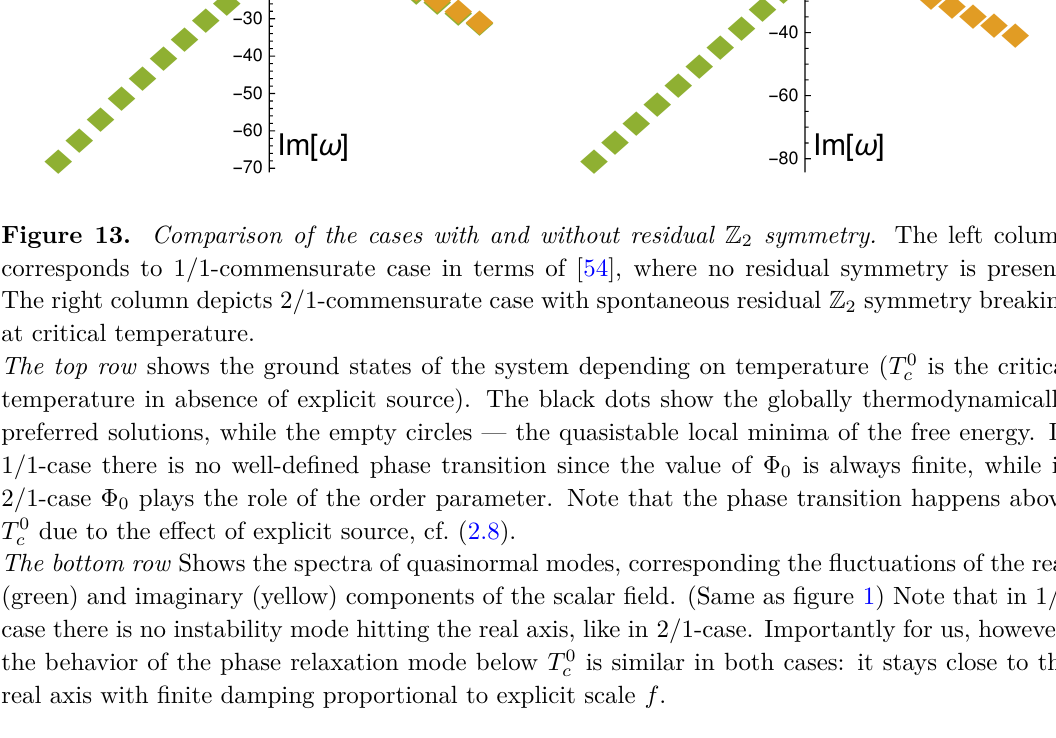
symmetry breaking 2